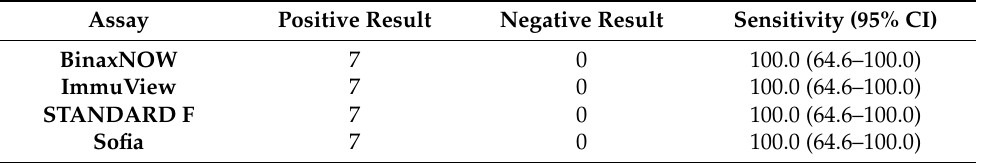
Table 1. Sensitivity of four Legionella urine antigen assays on samples *.